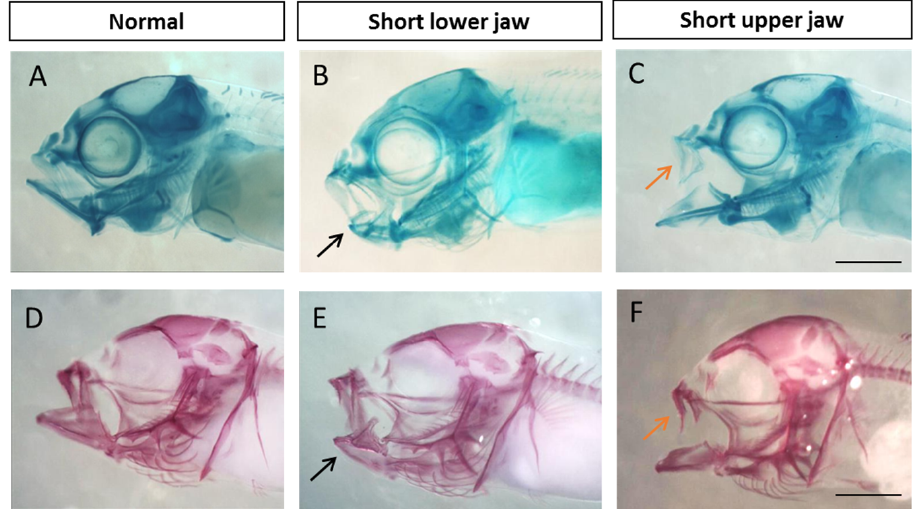
Figure 3. Cartilage and bone structures of normal ( A , D ) and jaw deformed ( B – C , E – F ) fi sh at 28 days post-hatch larvae. Cartilage stain ( A – C ) and bone stain ( D – F ). Dentary bone shorter (black arrow) in comparison to normal fi sh. Maxillary bone atrophied or non-developed does not connect to the dentary bone of the lower jaw (orange arrow). Scale bar: 2000 µm (2 mm).